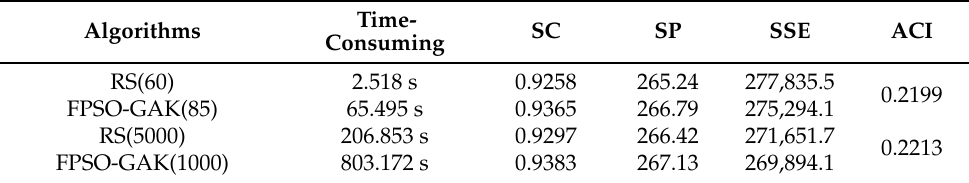
Table 2. Average indexes for clutering operations in synthetic dataset.